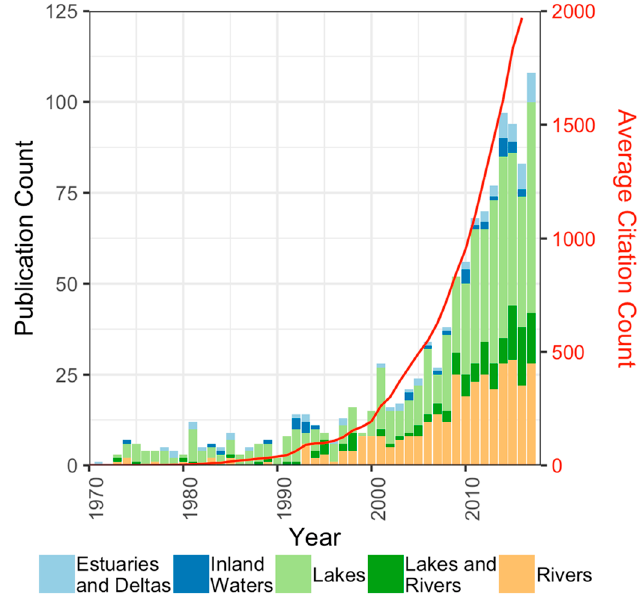
Figure 1. Published papers per year returned from Scopus search queries and grouped by search term. Average citation count is the sum of citations for all papers averaged over the number of years since their publication.